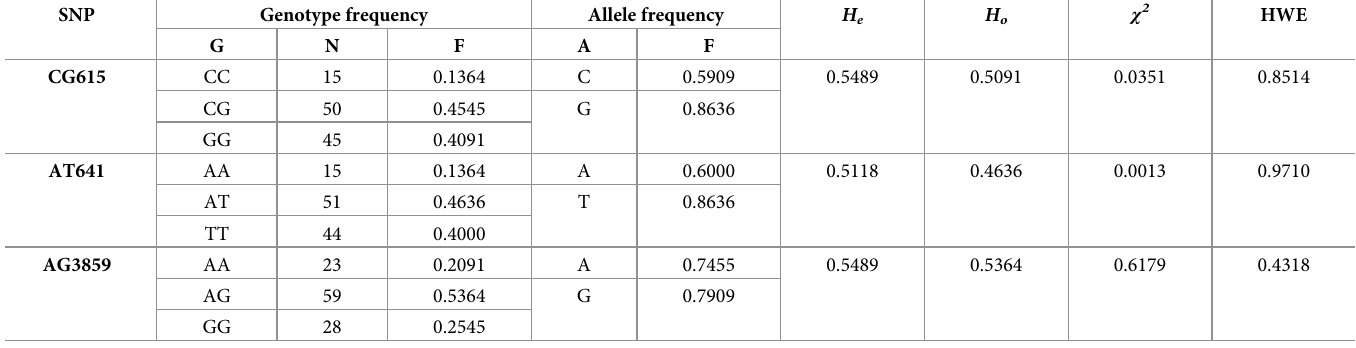
Table 5. Genotypes frequency and polymorphisms of 110 Pinus elliottii samples based on 3